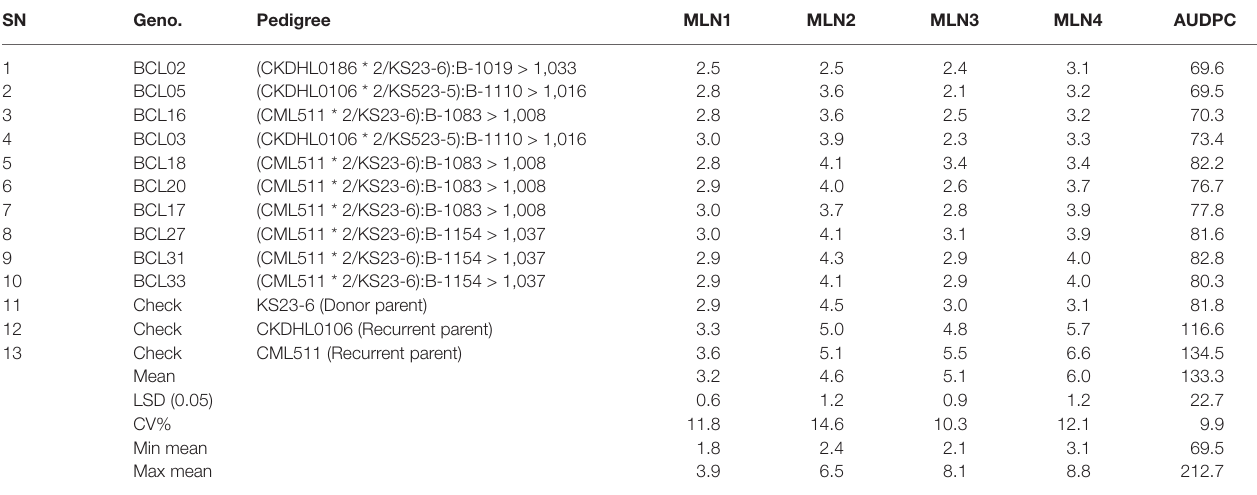
TABLE 5 | Mean scores and AUDPC for MLN severity for 10 resistant BC 3 F 2 lines compared to donor and susceptible parents evaluated under artificial MNL infections in Naivasha for two seasons in 2018. SN Geno.